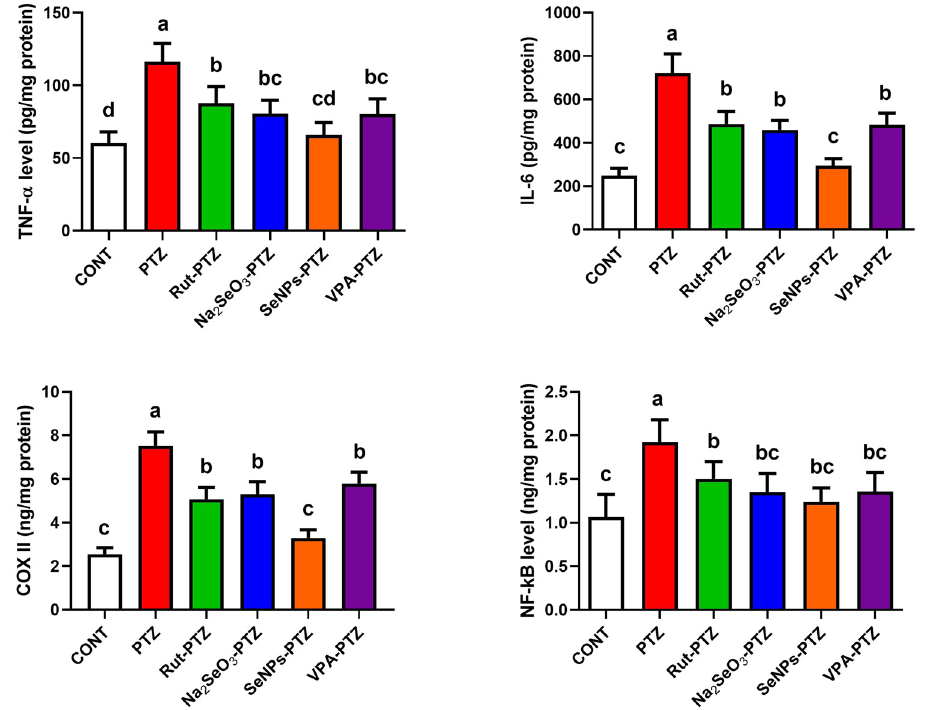
Figure 6: E ff ects of orally administered Rut, Na 2 SeO 3 , or Rut - SeNPs on the levels of in fl ammatory biomarkers ( IL - 6, TNF - α , COX II, and NF - κ B ) in the hippocampus of PTZ - injected epileptic mice. Di ff erent superscript letters indicate statistical signi fi cance at P < 0.05. All results are presented as the mean ±